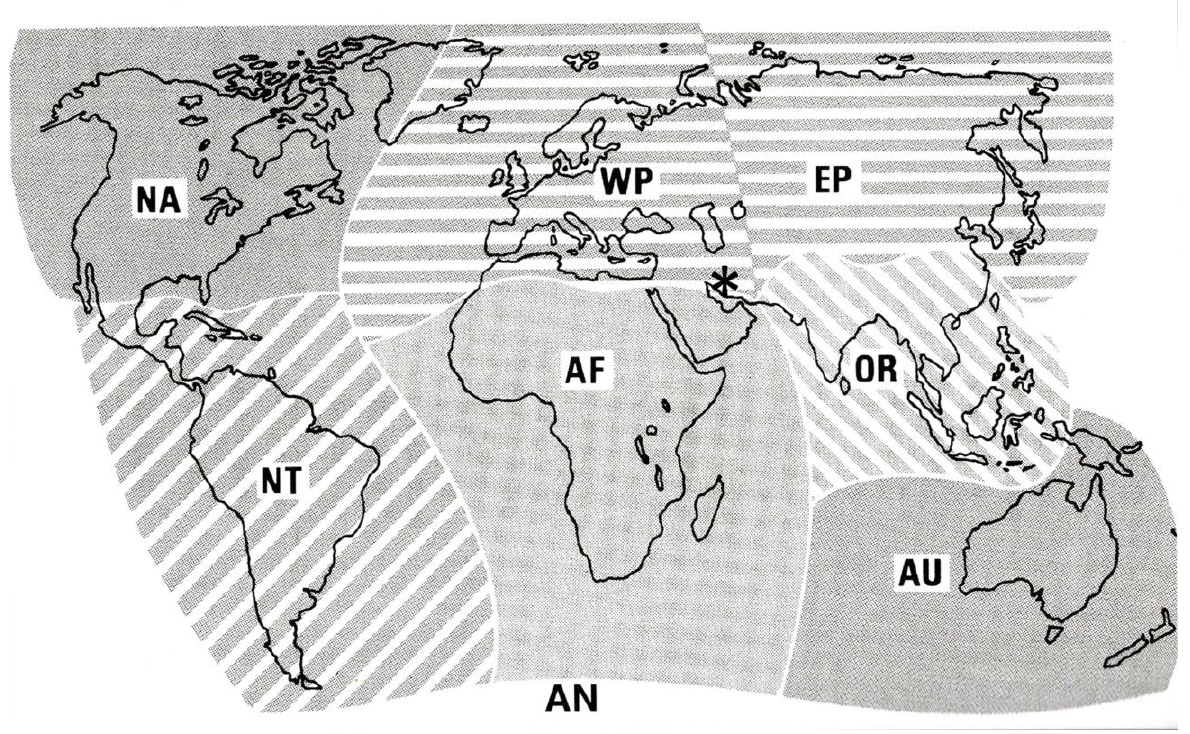
F IGURE 1. Map of global terrestrial zoogeographic regions showing the position of Fars province (southwestern Iran). AU (Australian), OR (Oriental or Indomalayan), EP (East Palearctic), WP (West Palearctic), AF (Afrotropical), NA (Nearctic), NT (Neotropical). (After Madjnoonian et al., 2005). * Indicated the Fars province